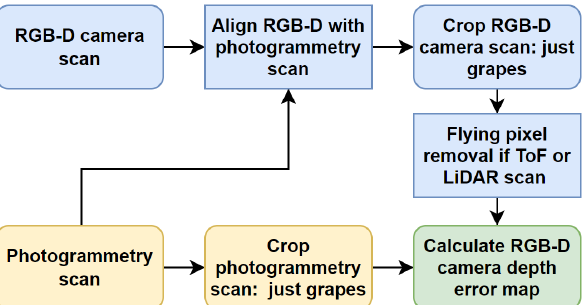
Figure 5. Diagram showing the processing steps used to calculate error depth maps for the RGB-D